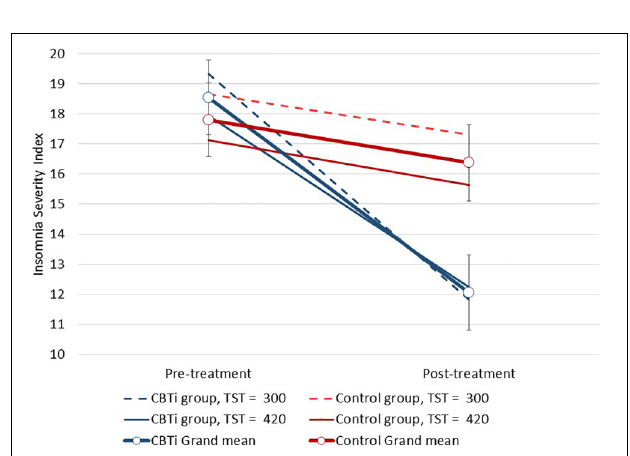
FIGURE 5 | Modeled data illustrating the effect of pre-treatment total sleep time, group (CBTi, control), and time (pre-treatment, post-treatment) on the Insomnia Severity Index (95%CI; not statistically significant). Pre-treatment sleep time was retained as a continuous predictor and data are plotted according to intercept, slopes and interaction